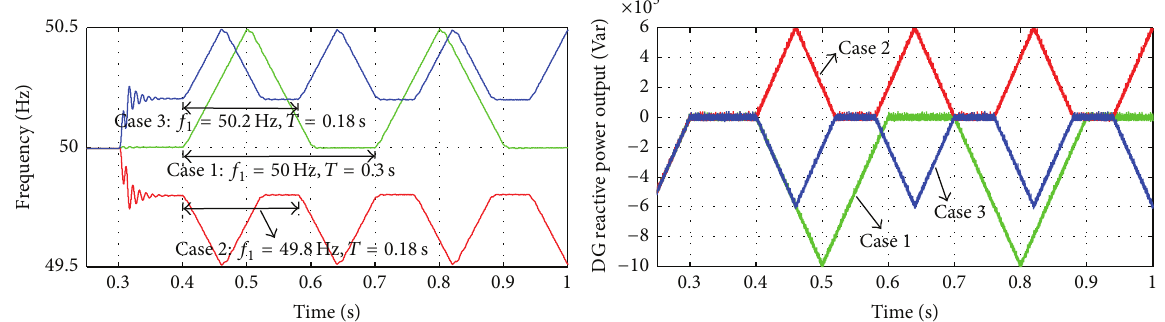
Figure 5: The PCC frequencies and reactive power output of the DG in the first scenario.